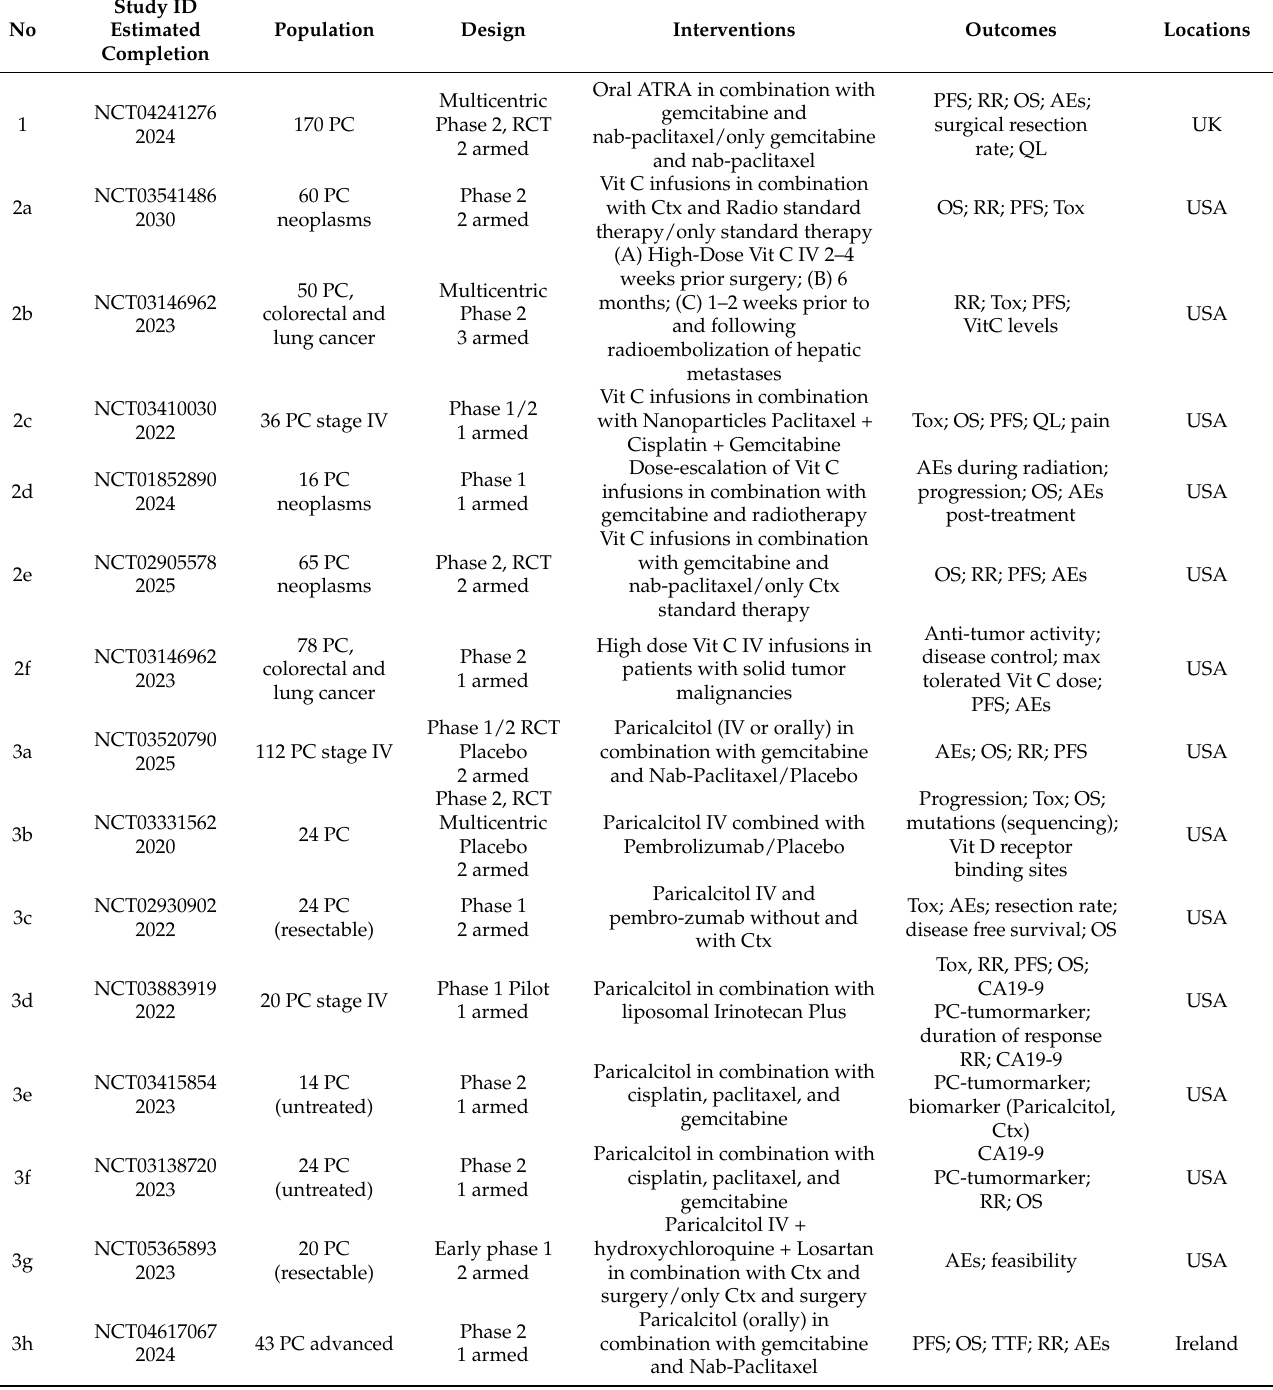
Table 1. Ongoing clinical trials for the treatment of pancreatic